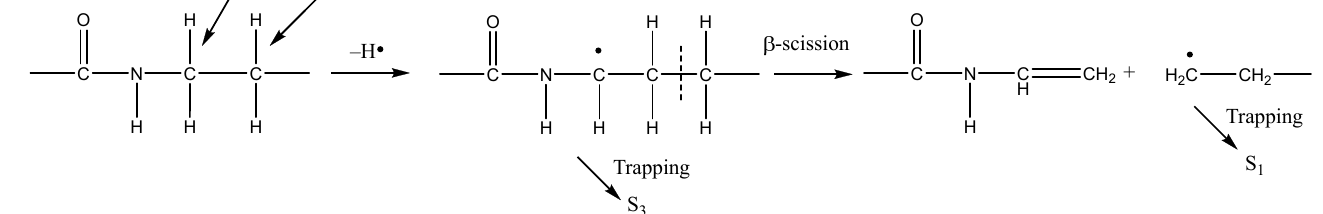
Scheme 1. Hydrogen abstraction of NH α methylene unit for the thermal degradation mechanism of PA66.